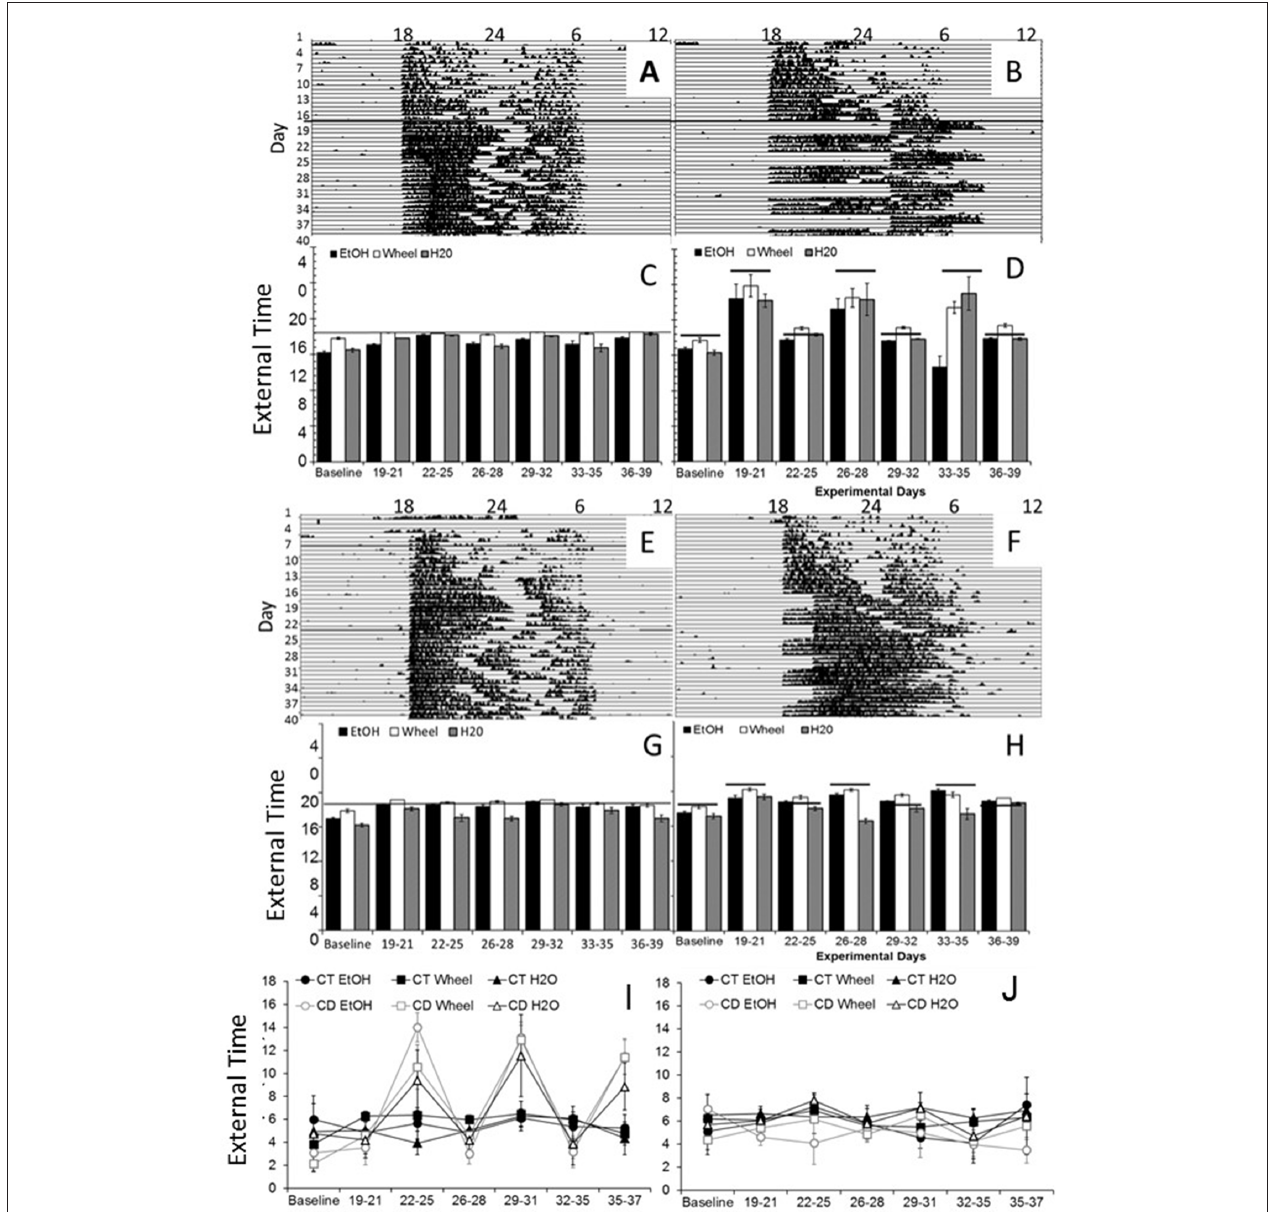
FIGURE 1 | Circadian patterns and period onsets in adolescent C57BL/6J mice during baseline alcohol access and environmental circadian desynchrony (CD). Representative actogram of wheel-running data from two mice in Experiment 1, one in the control condition (A) , and one in the CD condition (B) . Throughout the study, control mice showed normal circadian rhythms in all three measures (C) , with activity onsets at approximately the same time that lights were turned off (18:00, external time). During the CD photoperiods, mice were constantly shifting their behavior onsets to adjust to the phase advances and delays between the 12HR and 18HR photoperiods, respectively (D) . Representative actogram of wheel-running data from two mice in Experiment 2, one in the control condition (E) , and one in the CD condition (F) . Throughout the study, control mice showed normal circadian rhythms in all three measures (G) , with activity onsets at approximately the same time that lights were turned off (18:00). During the CD photoperiods, mice were constantly shifting their behavior onsets to adjust to the phase advances and delays between the 12HR and 6HR photoperiods (H) . Total activity (alpha) was higher in the mice in the 12HR photoperiod during CD across all measures in Experiment 1 (I) but there were no significant effects on alpha in Experiment 2 (J) (Data in C,D and G,H indicate the mean ± SEM for n =